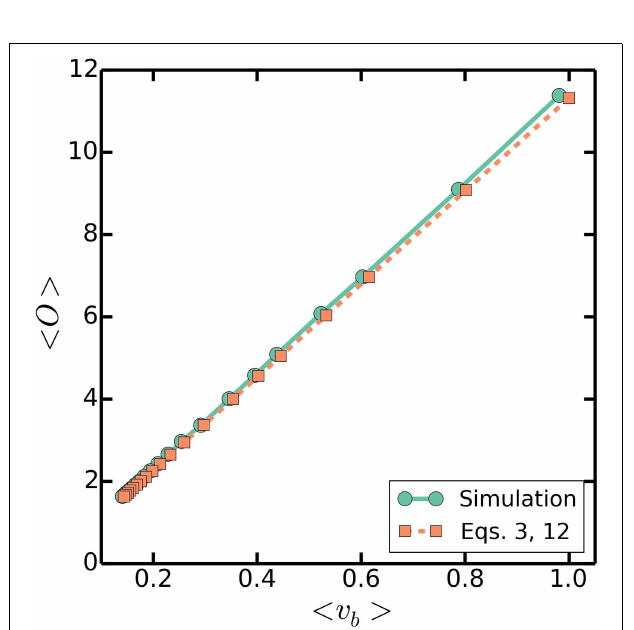
FIGURE 8 | Distribution of volumes at initiation. Simulations are as in . Simulations are as in Figure 3 , with a varying Figure 3 , with τ = 100 mins , C + D = 70 mins , and σ τ = 20 mins as a specific, τ = 20 − 100 mins , a fixed C + D = 70 mins , and σ τ /τ = 0 . 2 . Dashed line plots slow growth example. Square symbols separate volumes at initiation into two (Equations 3 and 12). subpopulations, one whose cells initiated the predicted number of rounds of replication at volumes near I 0 1 , and another whose cells initiated extra rounds of replication near twice that volume 2 I 0 1 . Solid lines plot